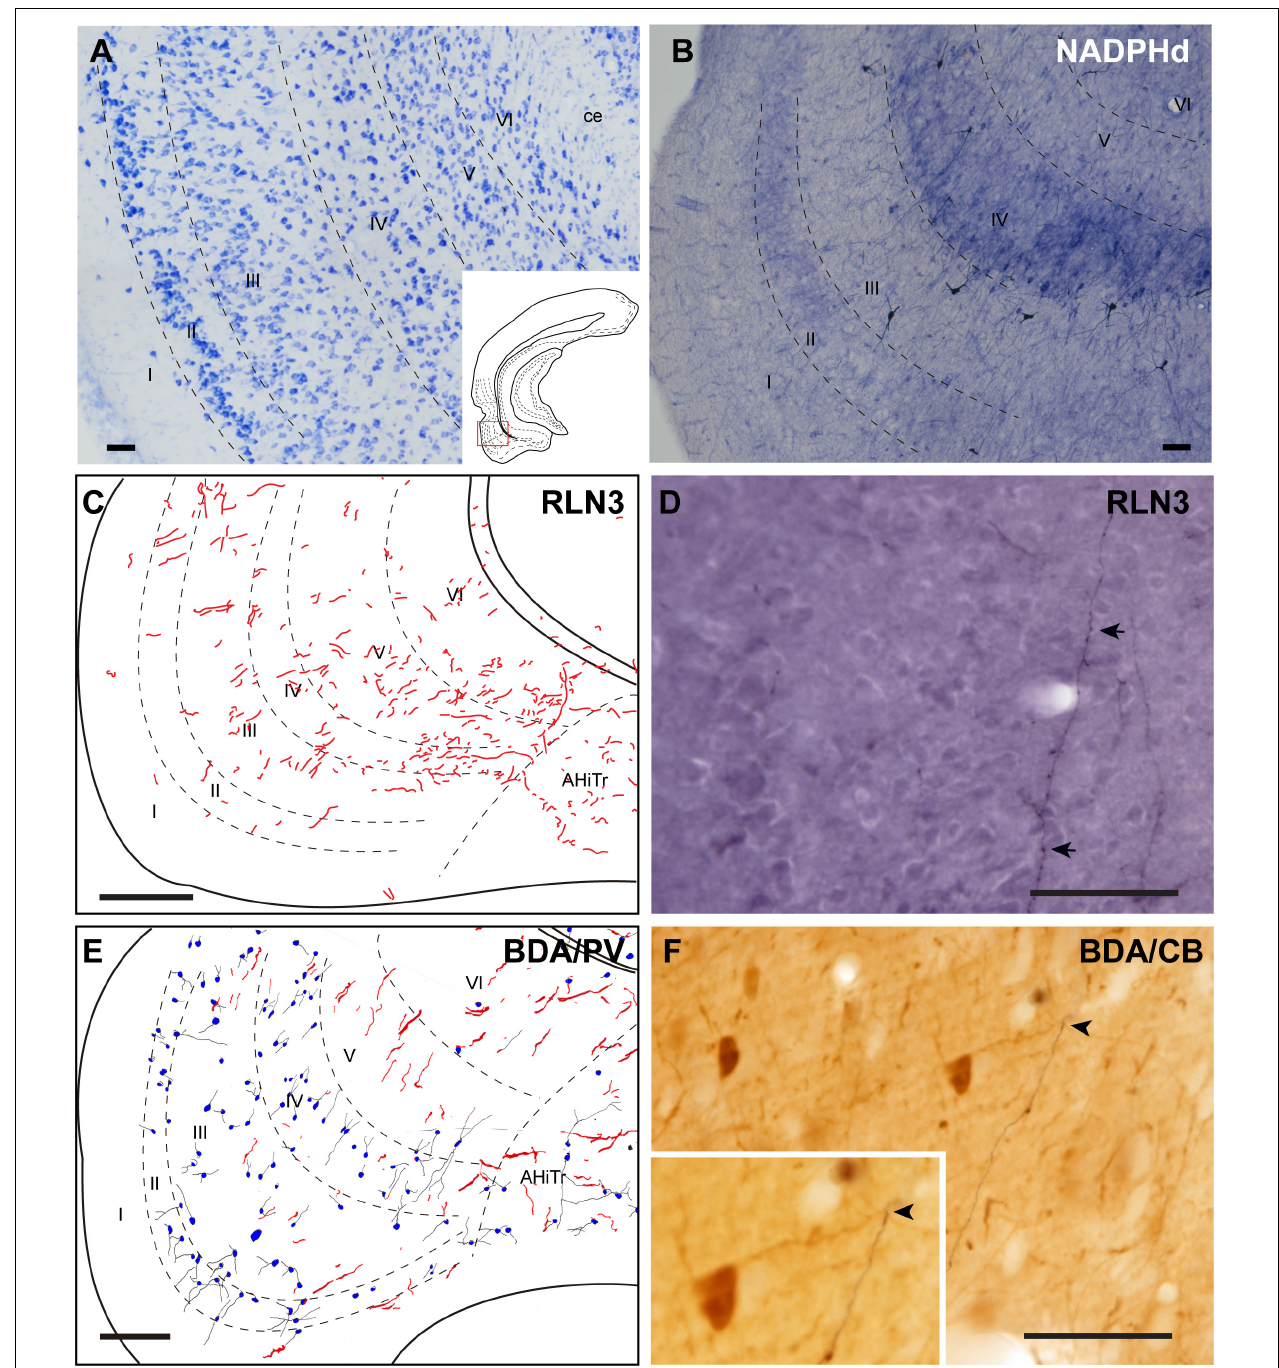
FIGURE 8 | Distribution of anterograde labeling and RLN3 staining in the lateral entorhinal cortex. (A) Giemsa stain. (B) NADPHd histochemistry revealed alternative layers of dense and sparse reaction. (C) Camera lucida drawings of RLN3 fibers. (D) Photomicrograph illustrating the appearance of RLN3-labeled fibers (arrows) in layer V, case N1. (E) Camera lucida drawing of sections labeled for BDA injected into the NI and for PV, case FH54. (F) Photomicrograph illustrating the appearance of labeling for BDA fibers (black) and PV neurons (brown) illustrating a close apposition (arrowheads) in layer V of the LEnt, case FH54. Calibration bars (A–F) 100 µ m.